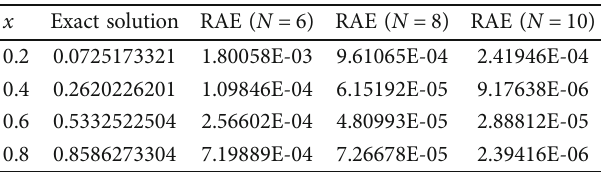
Table 3. We compare our solution with Jacobi-predictor- corrector algorithm [23]. Again, only using few terms of shifted Legendre polynomials, we were able to obtain good results compare with Jacobi-predictor-corrector algorithm. More speci fi cally, say if N = 10 has been used, the size of each subinterval is 0 : 1 , which is equivalent to the iteration Jacobi-predictor-corrector algorithm with stepsize 1/10 . For β = 3 , our absolute error is 4.779320E-07, ð N = 10 Þ , which is comparable with 7.4482E-07, stepsize = 1/10 .